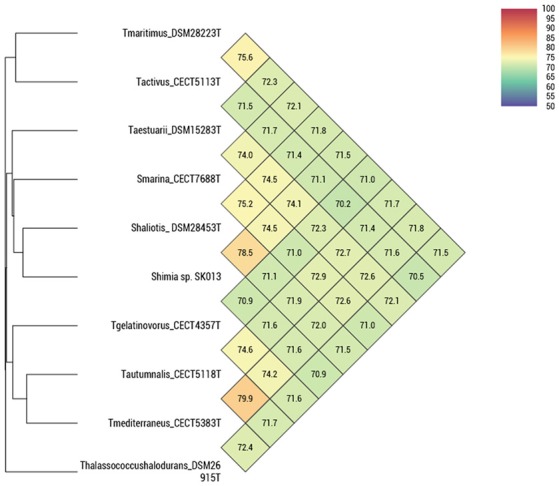
OrthoANI indices between pairs of Thalassobius, Shimia and Thalassococcus strains (according to Lee et al., 2016).